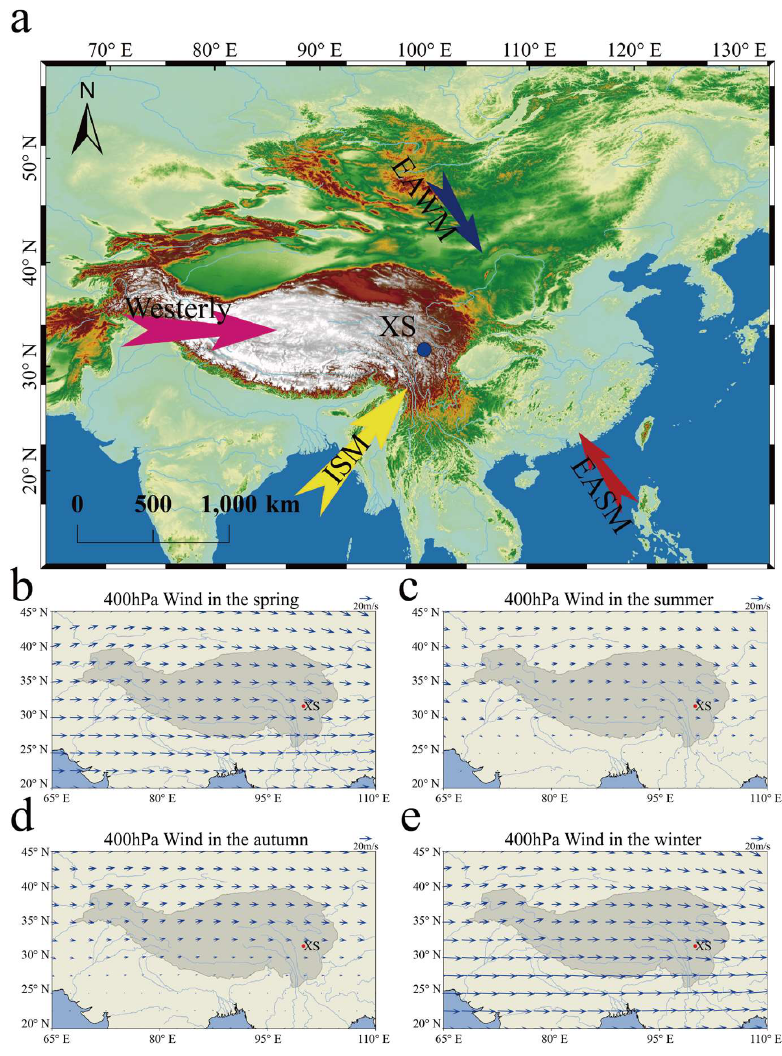
Figure 1. ( a ) The XS section is mainly affected by the westerlies, Indian summer monsoon (ISM), and Tibetan Plateau (TP) monsoon. The red dot is the location of the study site. Wind circulations at the 400 hPa levels in ( b ) spring, ( c ) summer, ( d ) autumn, and ( e ) winter during 1992–2021. The data used here were acquired from https://cds.climate.copernicus.eu/cdsapp#!/dataset/reanalysis-era5-pressure-levels-monthly-means?tab=form (accessed on 1 October 2022).